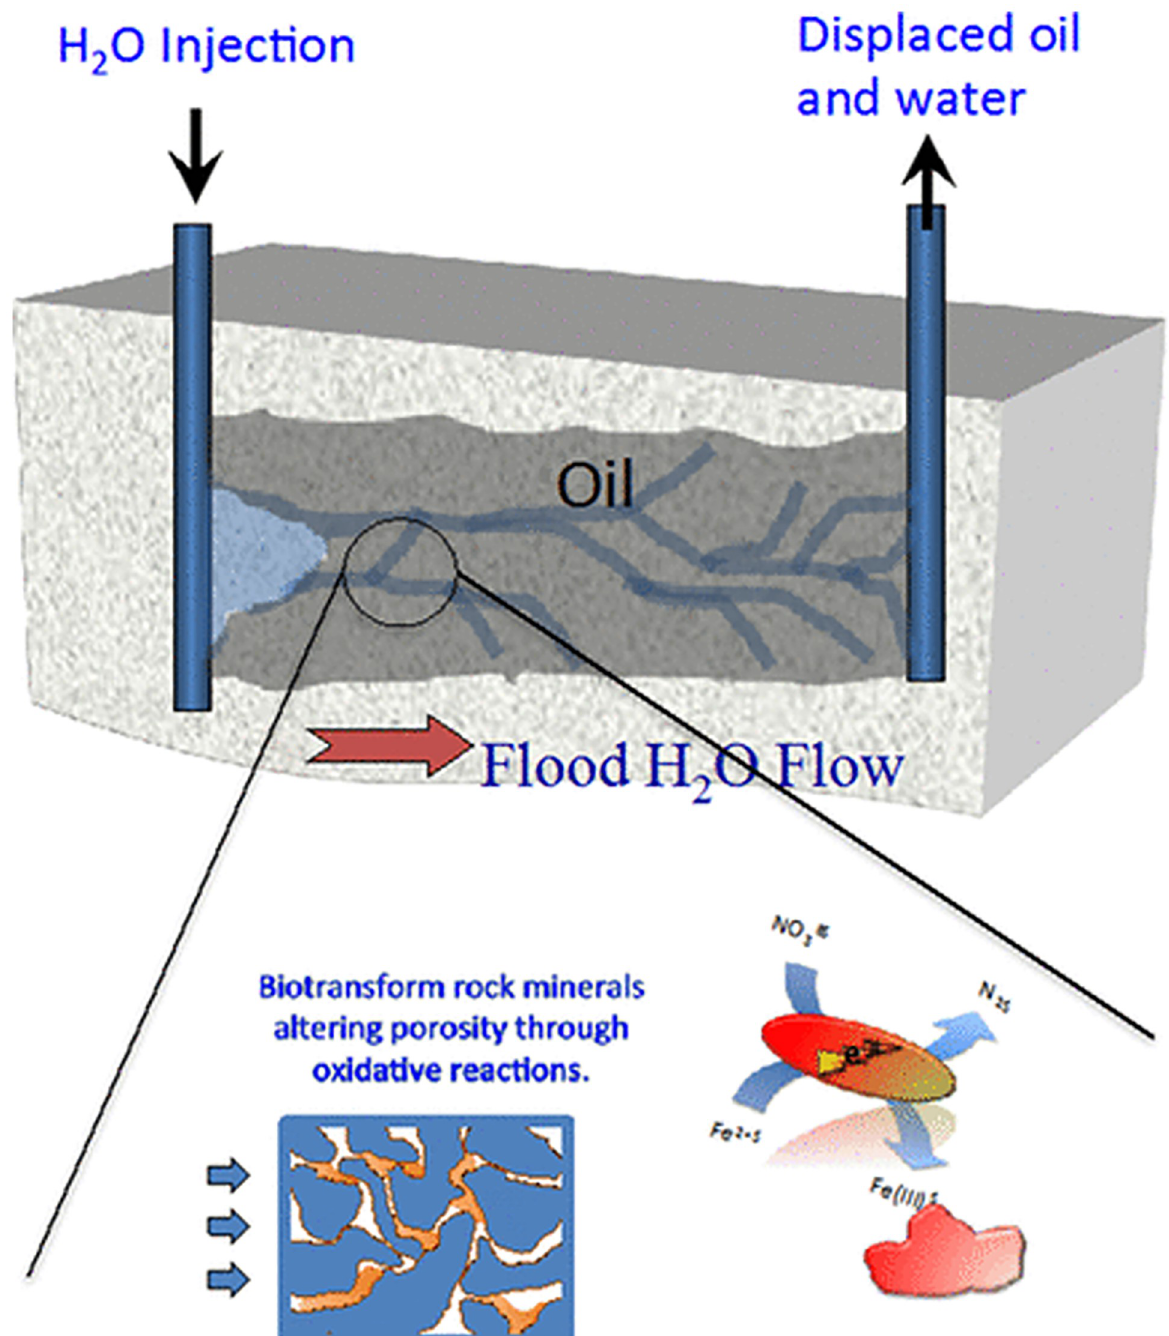
Fig 12. Reservoir profile control